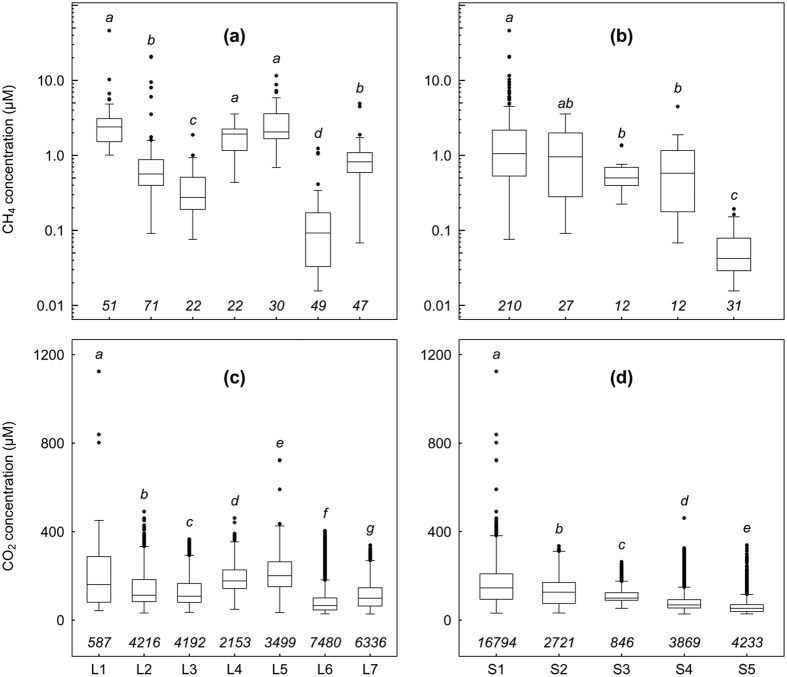
Boxplots of CH4 (a,b) and CO2 (c,d) concentrations measured in the streams grouped into location and slope categories. The boxes show quartiles and the median, the whiskers denote data within 1.5 times of the interquartile range and the black closed circles denote values outside the interquartile range. The letters above the boxes represent Tukey’s post-hoc test and boxes with different letters had significantly different concentrations (p < 0.05). The numbers below the boxes are the number of measurements in each category. Note the log10 scale in y-axis of panels (a,b). The concentrations in equilibrium with atmospheric concentrations are 0.004 μM and 23.5 μM for CH4 and CO2, respectively.